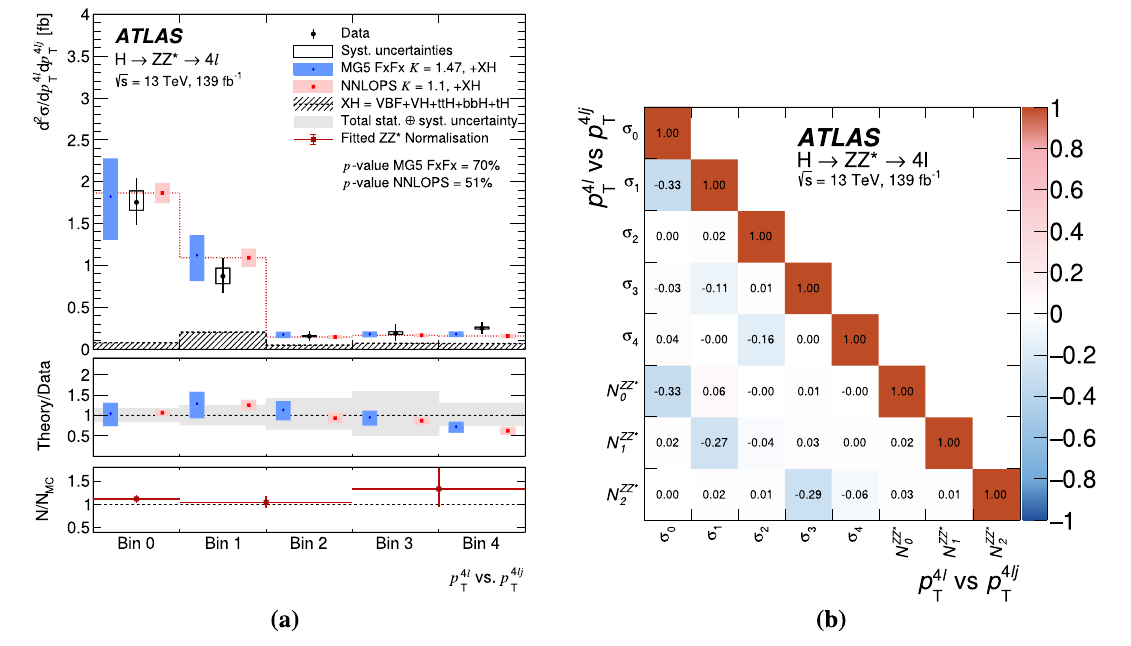
Fig. 35 a Differential fiducial cross section for the transverse momen- tum of the four-lepton system vs. the transverse momentum of the four- (cid:3) j lepton plus jet system, p 4 (cid:3) vs. p 4 and b the corresponding correlation T T